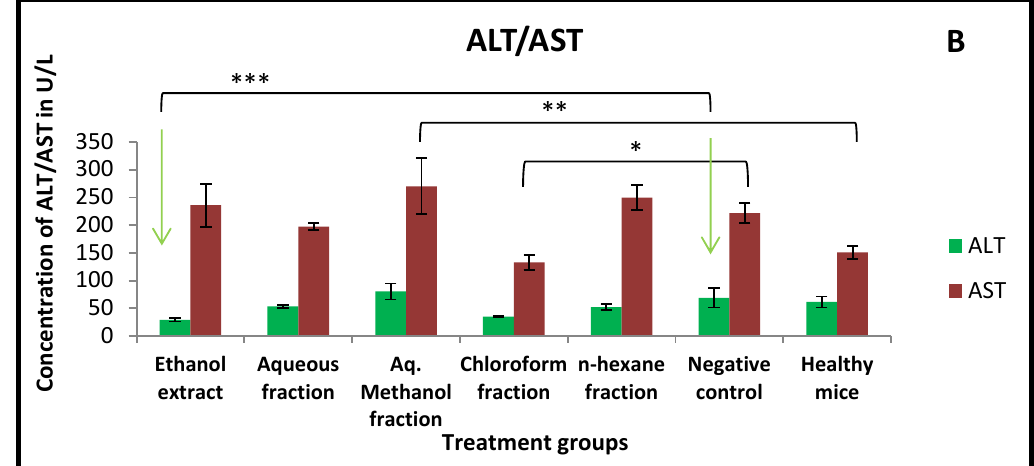
Figure 5. Effects of X. spinosum extract and fractions on ( A ) Creatinine ( B ) ALT and AST serum level after 10 days of treatment. (# p > 0.05) (* p = 0.004) (** p = 0.006) (*** p = 0.03). 2.7. Effect of X. spinosum Extract and Fractions on Lymphocytes Proliferation in the Presence and Absence of Mitogens Lymphocyte proliferation was slightly stimulated when treated with X. spinosum extract and fractions. As a matter of effectiveness, the n -hexane fraction showed the highest stimulation index in both conditions, with or without co-mitogen (stimulation index between 3.27 and 1.74) (Figure 6). At the higher tested concentration (100 mg mL − 1 ), the chloroform fraction exhibited activity parallel to the n -hexane fraction with a stimulation index range between 2.7 and 1.58 (Figure 6).